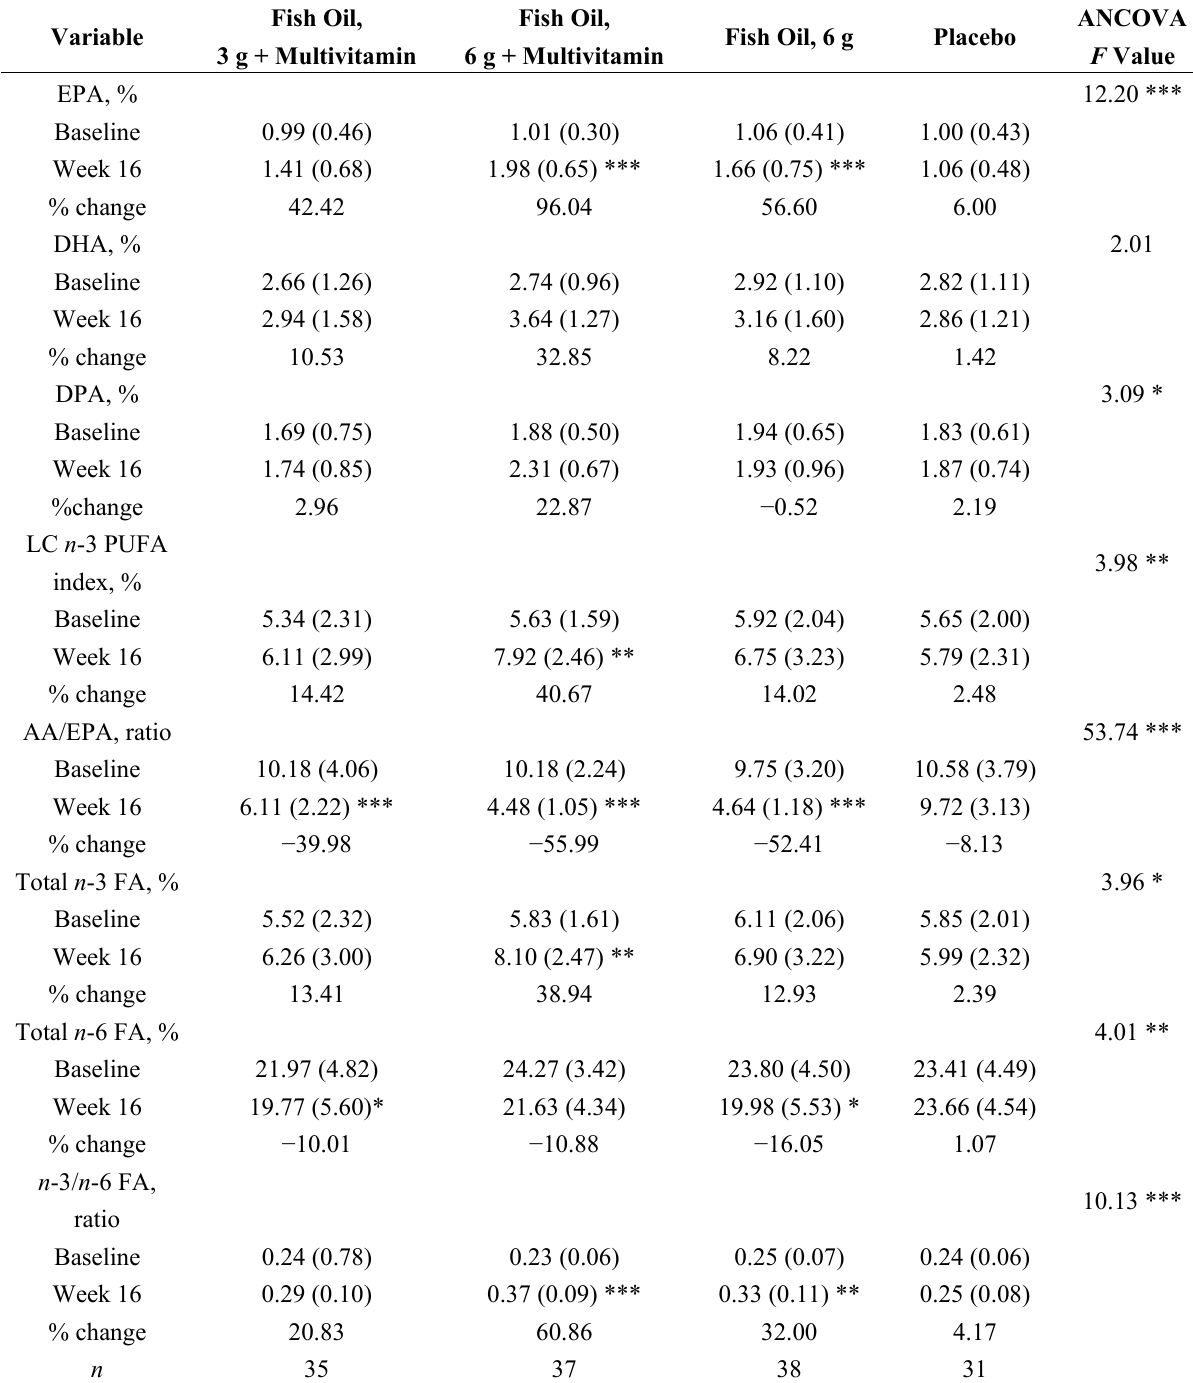
Table 2. Means, standard deviations and percentage change for red blood cell fatty acid status over the course of